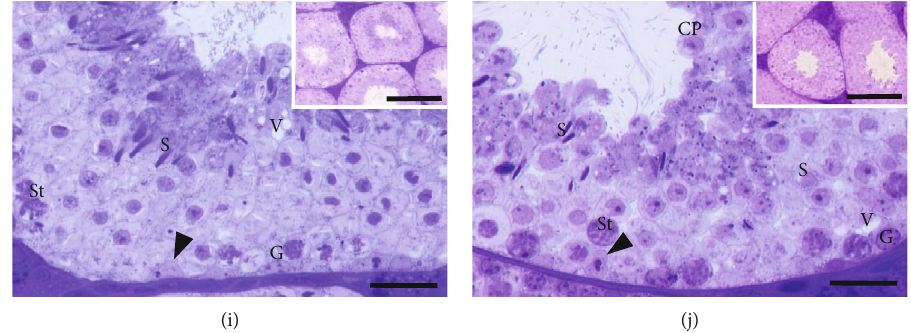
Figure 1: Seminiferous cords/tubules of the testes of control and animals with nicotine administration. (a) Control of 3dpp, where we could observe subtype II gonocytes with cytoplasmic projections extending toward the basement membrane (short arrow) and subtype III gonocytes in contact with the basement membrane (large arrow) and Sertoli cell. (b) The nicotine group of 3dpp, where we can appreciate subtype I and II gonocytes (some of which are not in contact with the basement membrane), degenerated gonocytes (arrow), and Sertoli cell. (c) Control of 7dpp subtype III gonocytes in contact with the basement membrane, type A spermatogonia, and Sertoli cell can be appreciated. (d) The nicotine group of 7dpp, where we can observe degenerated subtype III gonocytes, giant gonocytes (short arrow), and Sertoli cell. Some cords did not have germ cells (large arrow). (e) Control of 10 dpp; gonocytes are not observed. There are spermatogonia in contact with the basement membrane and a great number of Sertoli cells. (f) Nicotine of 10 dpp. Germ cells without contact with the basement membrane (large arrow); some of these in degeneration (d) and Sertoli cell can be observed. (g) Control of 16dpp, where we can observe spermatogonia, a great number of pachytene spermatocytes, Sertoli cells, and tubular lumen. (h) The nicotine group of 16dpp showing spermatogonia and a lower number of spermatocytes without tubular lumen. (i) Control of 35 dpp. A clear spermatogenesis with spermatogonia, spermatocytes, spermatids, Sertoli cell, and mild vacuolization (V) can be observed. (j) The nicotine group of 35 dpp, where we can observe the same characteristics as in (i) and mild cellular peeling. The insertions show the general panorama of the seminiferous cords/tubules. I = subtype I gonocytes; II = subtype II gonocytes; III = subtype III gonocytes; arrowhead = Sertoli cell nucleus; G = spermatogonia; St = spermatocyte; S = spermatids; D = cells in degeneration; V = vacuolization; CP = cellular peeling. Toluidine blue. Bar scale: 20 μ m, insertion bar scale: 150 μ